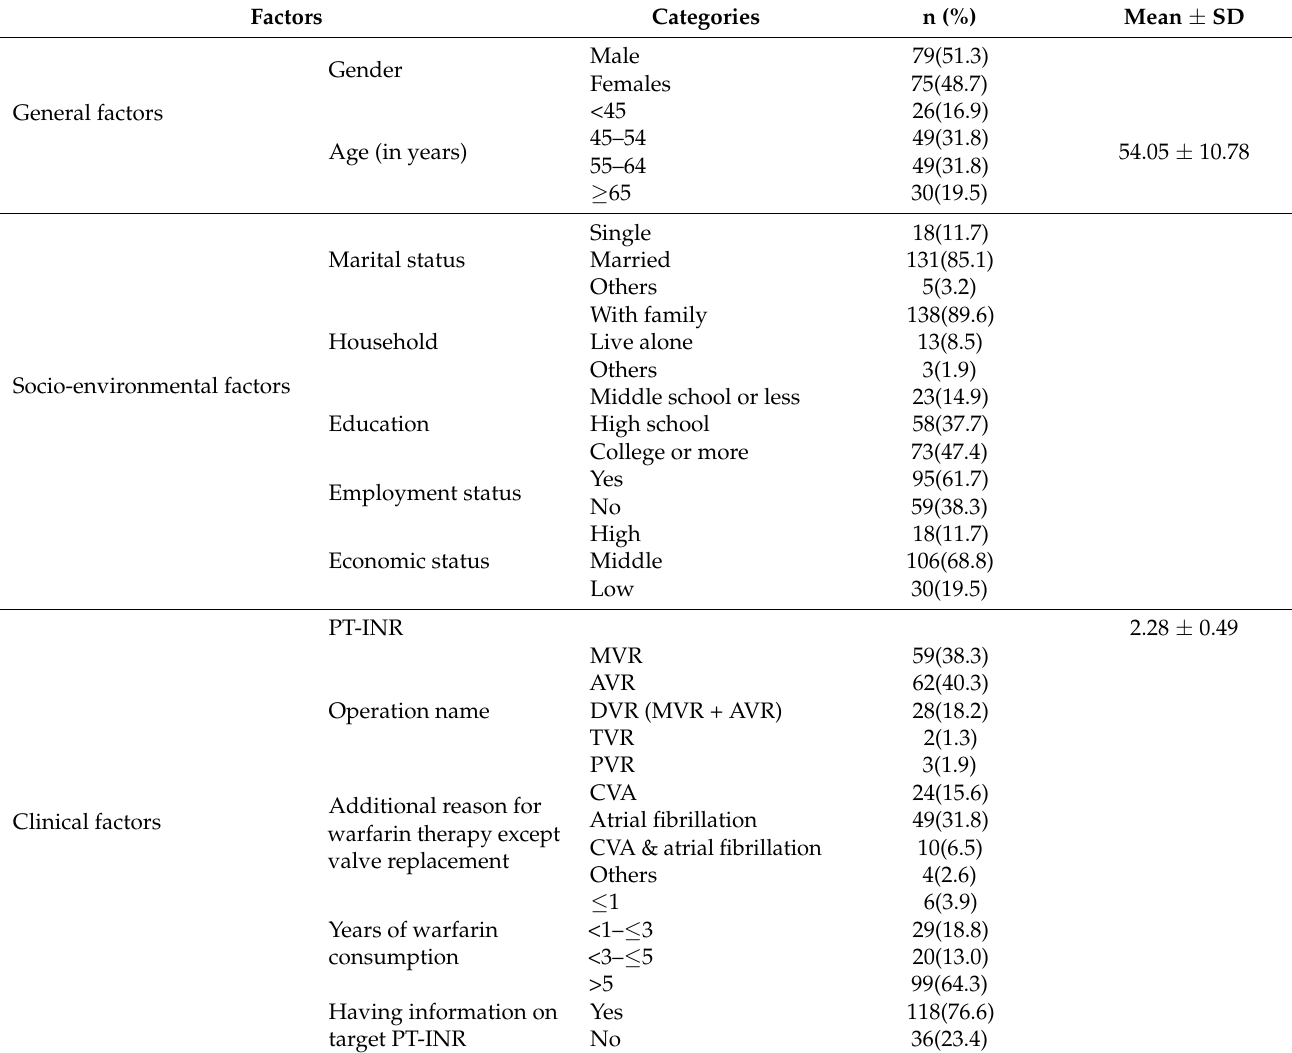
Table 1. General characteristics and clinical details of participants (n =